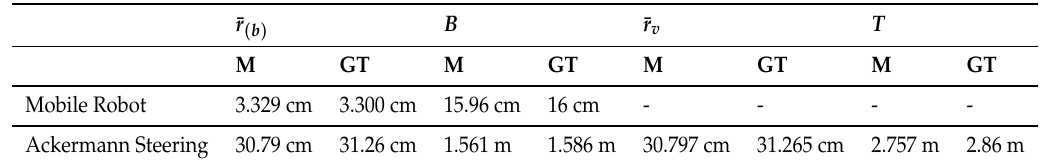
Figure 9. Estimation of T using the instantaneous center of rotation (ICR). The used bin size is 0.05 m. Table 1. Summarized results of derived vehicle parameters from the sGP motion models (M) and simulated ground truth (GT).